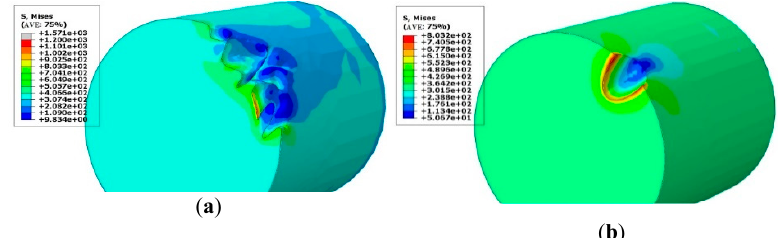
Figure 18. Stress contours of random pit model and two hemi-ellipsoidal pit models with mass loss rate of 2.5%. ( a ) Random corrosion pit; ( b ) Hemi-ellipsoidal corrosion pit ( λ = 0.5).